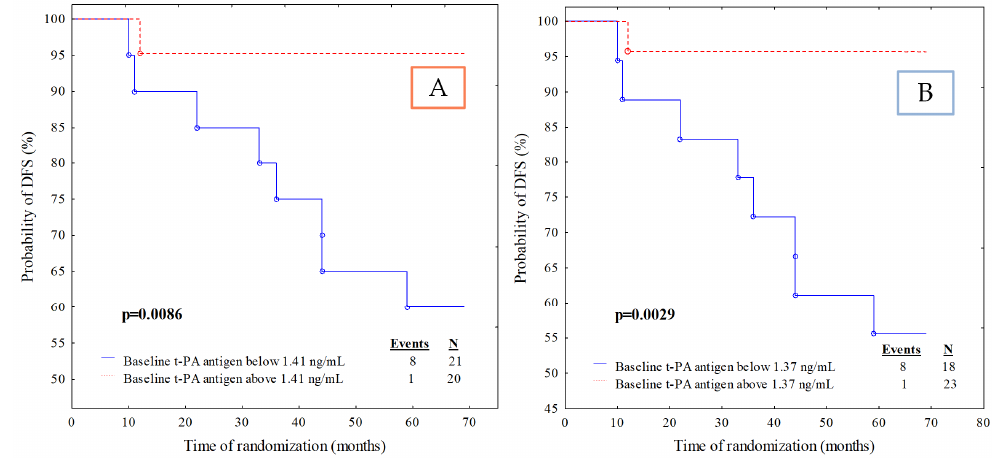
Figure 3. Kaplan–Meier curves for the disease-free survival (DFS) analysis of the studied population regarding ( A ) t-PA antigen divided according to median value cut-off; ( B ) t-PA antigen divided according to ROC cut-off.